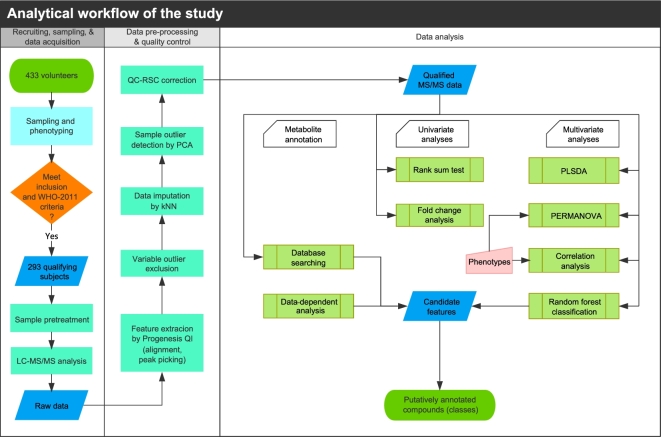
Flowchart for participant recruitment and data processing. The recruitment of participants was based on the 2011 World Health Organization criteria for diabetes and prediabetes diagnoses. Blood and clinical data were acquired from 293 qualifying subjects, and untargeted lipidomics liquid chromatography–tandem mass spectrometry analysis was performed. The raw data were preprocessed with Progenesis QI 2.0 to extract metabolic features. Unqualified variables and samples were detected and discarded using the BGI in-house program metaX [15]. Several types of statistical analyses such as rank sum tests, fold change analysis, partial least squares discriminant analysis, and random forest analysis were performed to identify metabolites that differed significantly between the diagnostic groups. The lipid compounds selected by the RF classifiers were identified by matching their accurate masses and mass spectrometryE ion spectral fragmentation patterns to those in the database. Data-dependent acquisition analysis was applied to improve the resolving power for identification. See the Methods for more details.